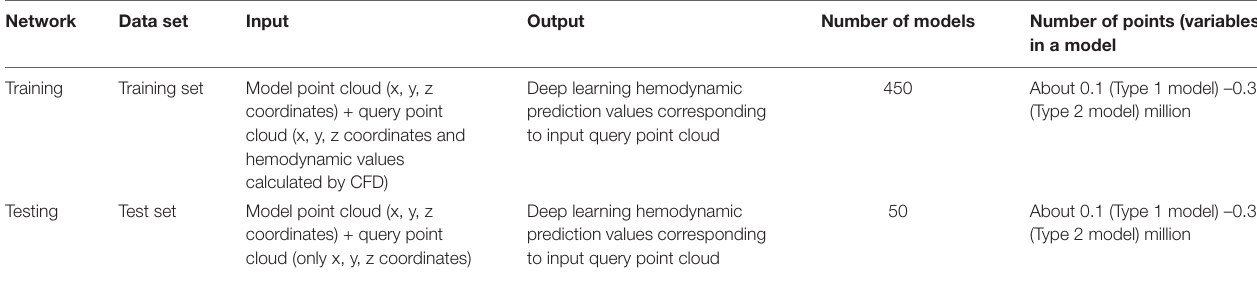
TABLE 2 | The usage details of data sets during network training and testing.